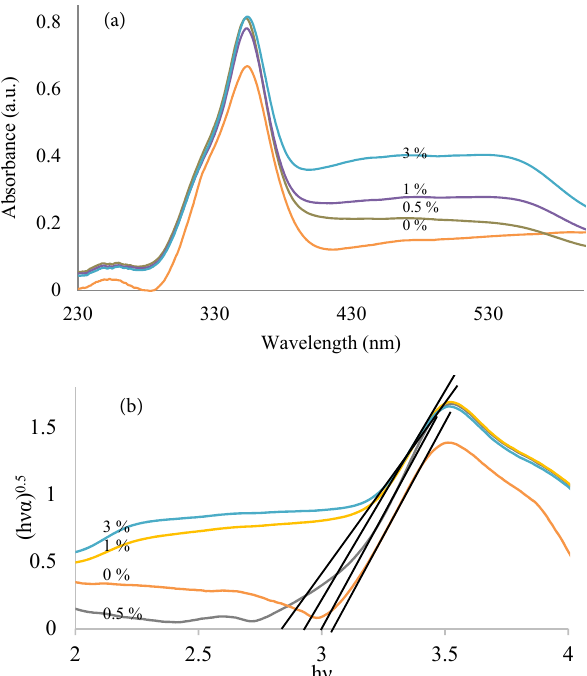
Fig. 4. UV/vis reflectance spectra of TiO